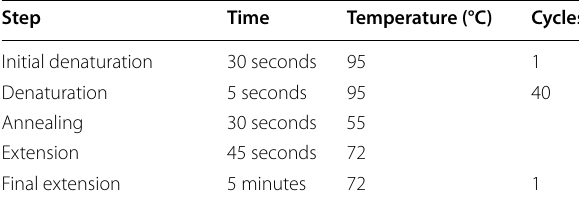
Table 2 The RT-PCR reaction profile Step Time Temperature (°C)